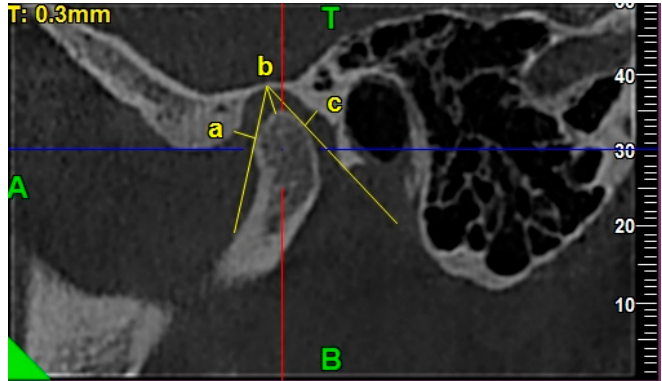
Figure 5. The exemplary lines, points, and angles in the TMJ CBCT scans used for measurements regarding the assessment of anterior, posterior, and superior joint spaces in the sagittal view: / a / anterior joint space, / b / superior joint space, and / c / posterior joint space.